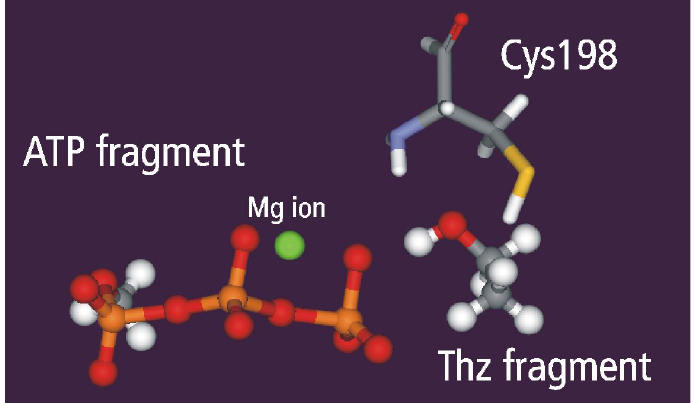
Figure 4. Gas phase optimized geometry of investigated models (with cysteine residue shown in stick